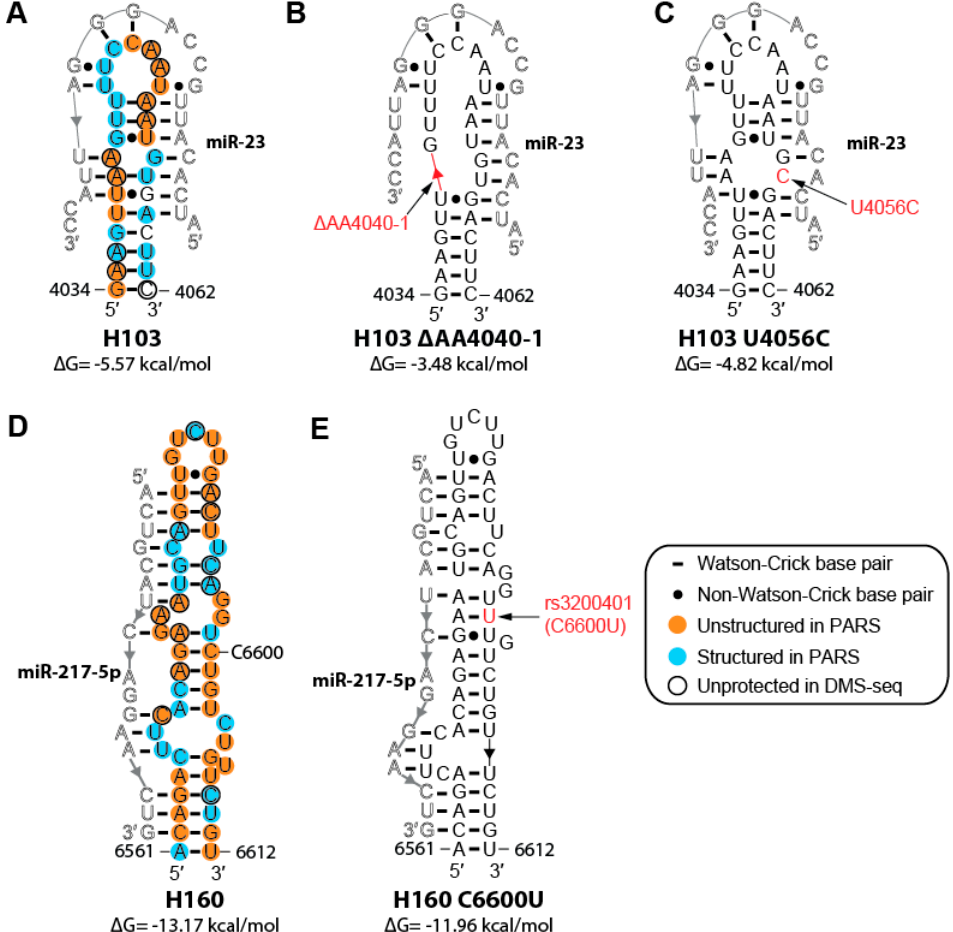
Figure 6. Predicted structural changes of helices and miRNA-binding sites by cancer-associated mutations and by SNP rs3200401. Schematics of the secondary structure of human H103 interacting with miR-23 [65,66] for ( A ) WT MALAT1, ( B ) the A4040/A4041 double deletion (red line) in breast invasive carcinoma (BRCA) [63], and ( C ) the U4056C substitution (red) in uterine corpus endometrial carcinoma (UCEC) [63]. Schematics of the secondary structure of human H160 interacting with miR-217-5p [16] for ( D ) WT MALAT1 and ( E ) the C6600U (red) SNP. All PARS and DMS-seq data are annotated as described in Figure 2. Predicted secondary structures and Δ G values of H103 and H160 mutants were determined using RNAfold [32].